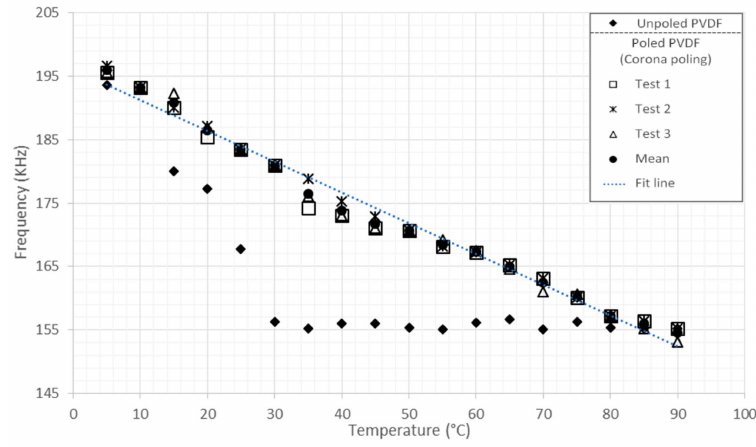
Figure 9. Thermal response of prostheses made of PVDF from 2 ˝ C to 90 ˝